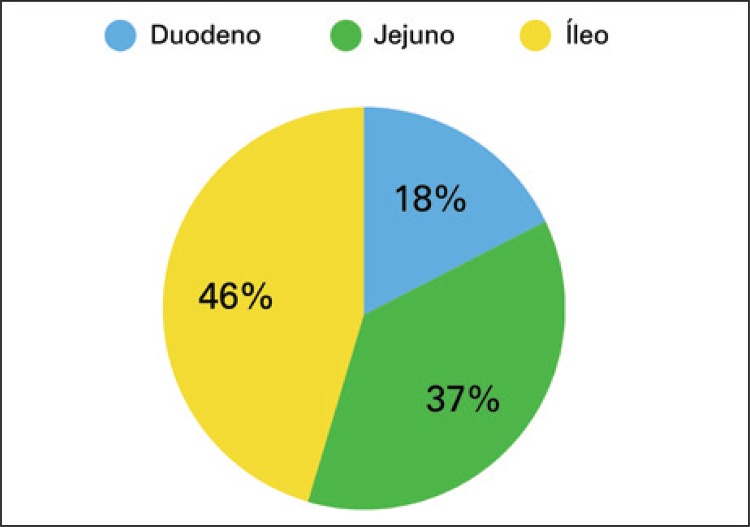
Localização do tumor no intestino delgado